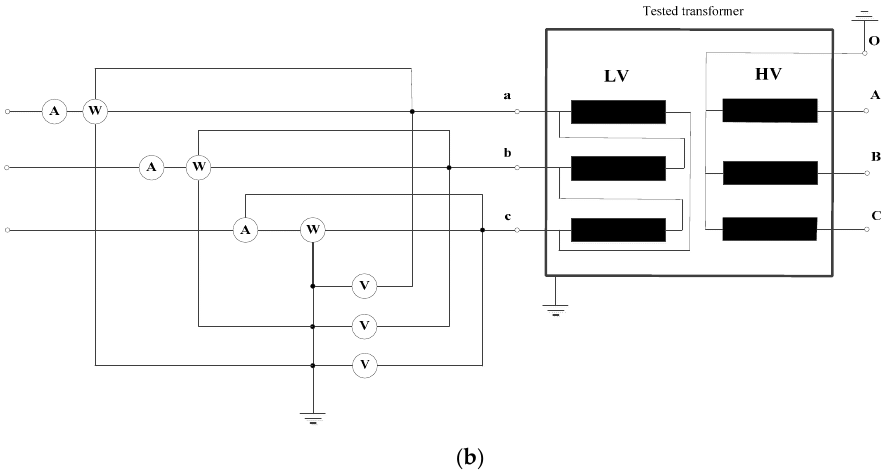
Figure 3. ( a ) Schematic diagram of load test and ( b ) Schematic diagram of no-load test.